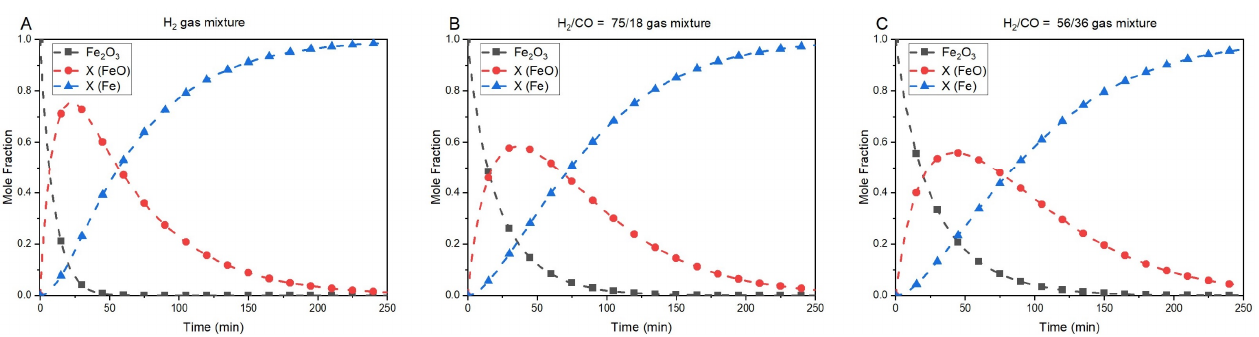
Figure 13. Mole Fraction vs. Time curves of Fe 2 O 3 , FeO & Fe for ( A ) H 2 gas mixture (experiment 3), ( B ) H 2 /CO = 75/18 gas mixture (experiment 10) and ( C ) H 2 /CO = 56/36 gas mixture (experiment 12) obtained using the 2D-axisymmetric model.